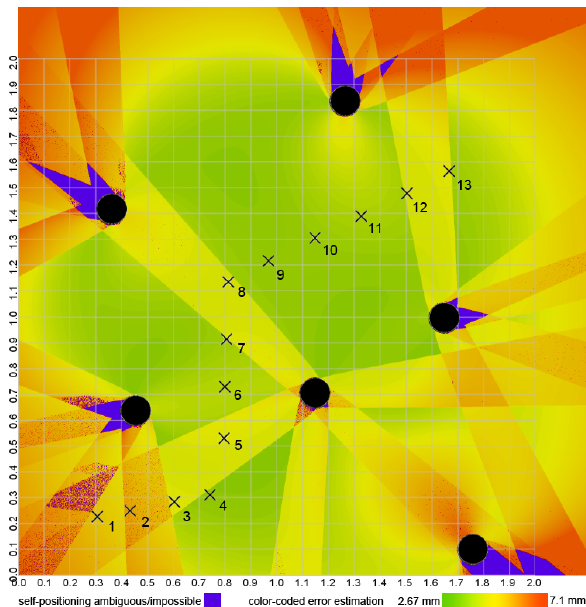
Figure 4: Accuracy color map for one landmark constellation (gray circles) and example trajectory.